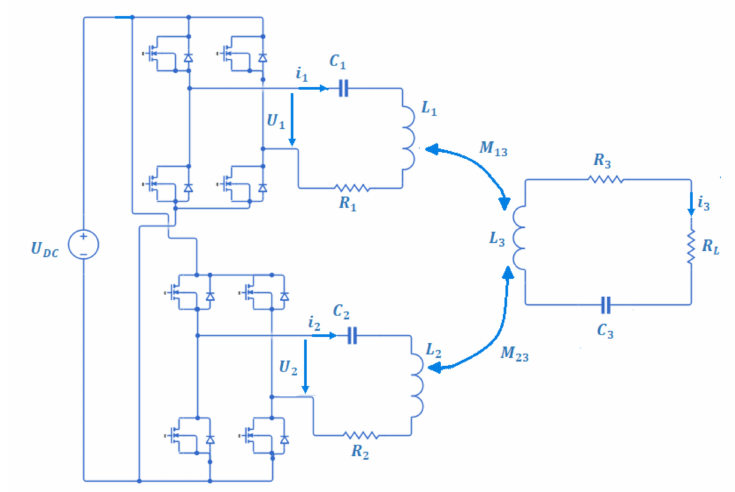
Figure 2. Equivalent circuit modeling of the 2D WPT